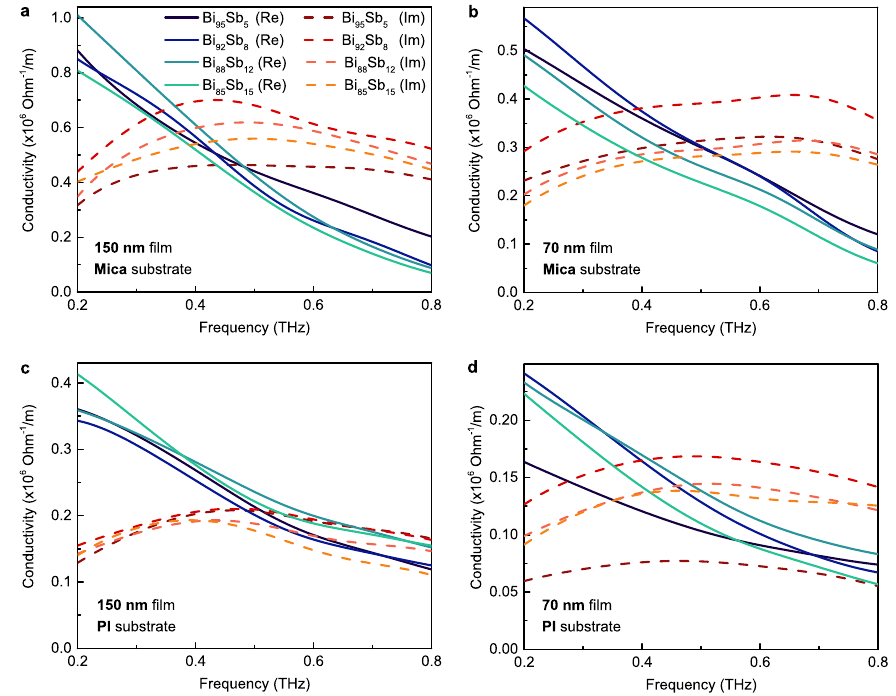
Figure 4. The dynamical complex conductivity spectra of Bi 1 − x Sb x films in 0.2–0.8 THz frequency range for the cases of mica ( a , b ) and PI ( c , d ) substrates and for 150 nm ( a , c ) and 70 nm ( b , d ) film thicknesses. Different colors represent different Sb concentrations. The solid and dashed lines represent the real and imaginary parts of conductivity,